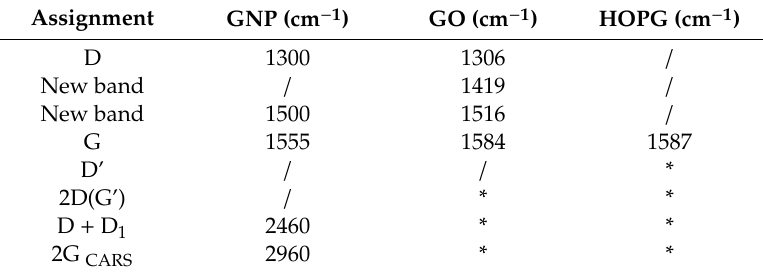
Figure 13. ( a ) The Raman of highly oriented pyrolytic graphite (HOPG) and single-layer graphene, and the CARS of HOPG: (1) The Raman spectrum of Highly oriented pyrolytic graphite (HOPG) (2) The CARS spectrum of HOPG, a blue shift of 7 cm − 1 relative to Raman toward the large wavenumber region (3) Raman spectra of monolayer graphene on Cu substrate. ( b ) Raman spectra of graphene oxide (GO) and graphene nanoplatelets (GNPs) at 1200 cm − 1 to 1700 cm − 1 wavenumber. ( c ) CARS spectra of GO and GNPs. ( d ) Comparison of Raman and CARS spectra of GNPs at 2400 to 3200 cm − 1 , 2D peak in Raman spectrum (2595 cm − 1 ), and its shoulders disappear in the CARS spectrum, but two new peaks of 1150 cm − 1 (considered to be a combination of D+D 1 (approximately 1150 cm − 1 ) modes) and 2960 cm − 1 (considered to be 2GCARS) appeared in its CARS spectrum. Reproduced from [101]. ( e ) CARS spectral sweep of graphene at 1330 cm − 1 Raman wavenumber. Reproduced from [95] ( f ) Image of h-BN under optical microscope, SRS, CARS, and SHG. ( g ) Raman and SRS scanning image and calibration spectrum of the same h-BN. Reproduced from [48], with permission from American Chemical Society, 2019. ( h ) Comparison of normalized CARS spectra of two-layer and three-layer graphene. ( i ) Classification result of test data by support vector machine (SVM) classifier, the percentage above the column is the accuracy rate. Table 2. CARS bands of graphene nanoplatelets (GNPs), graphene oxide (GO), and highly oriented pyrolytic graphite (HOPG). Reproduced from [101]. (* means no test, / means there is no such characteristic peak).